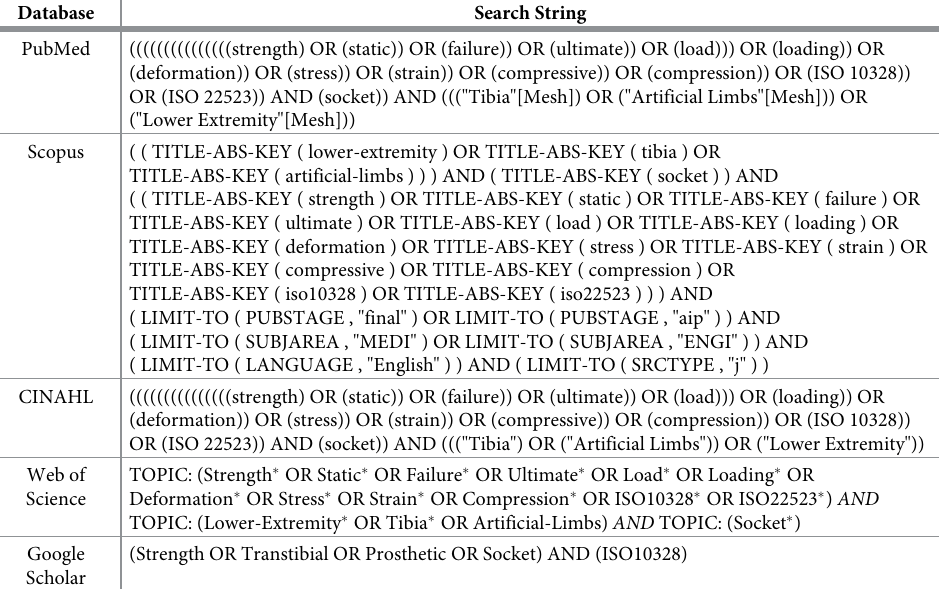
Table 1. Search strings used in each